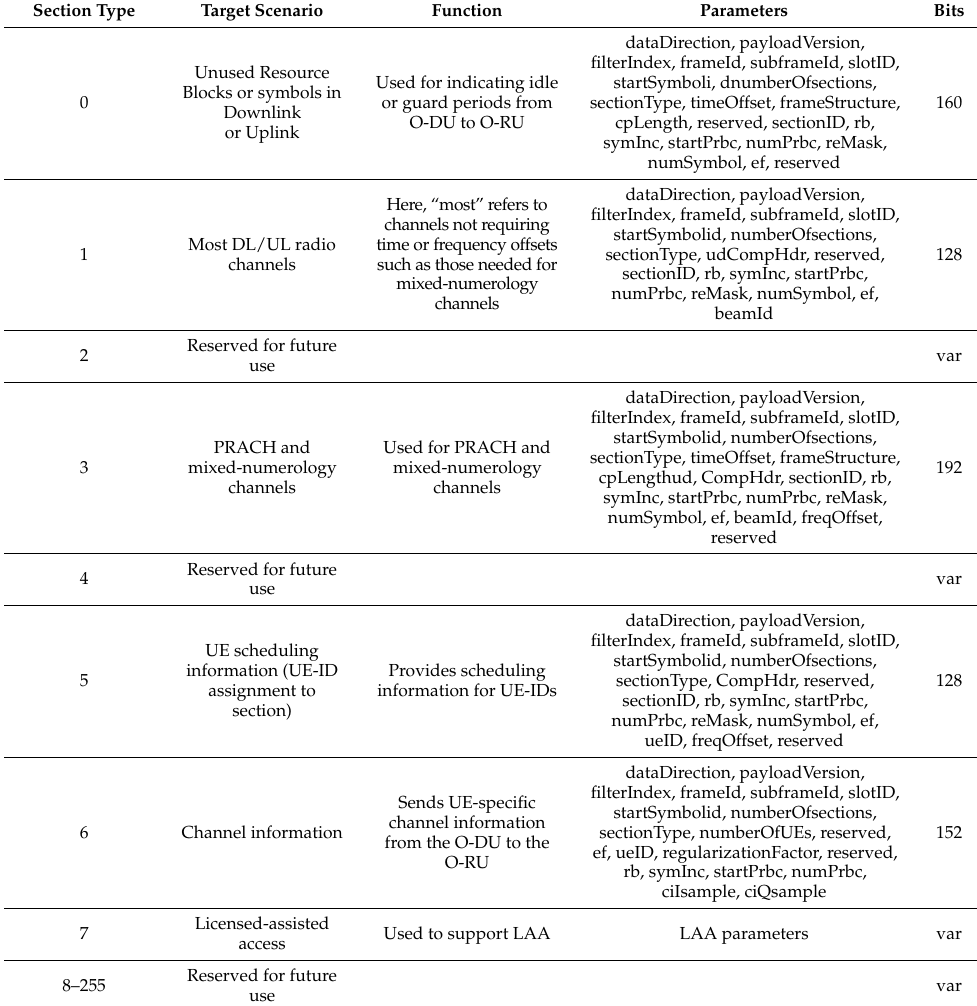
Table 2. Number of bits of the application and the section layer for each section type